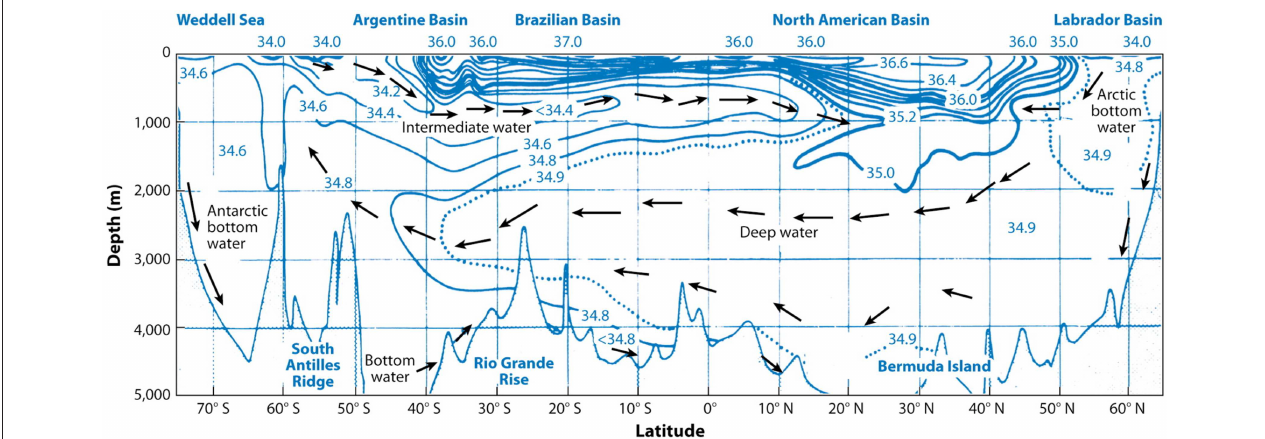
FIGURE 1 | Meridional section of salinity in the western Atlantic. Blue contours show isolines of salinity and also outline the bottom topography. Black arrows indicate directions of ocean circulation. From Lozier (2012). Copyright permission for this figure was granted by Annual